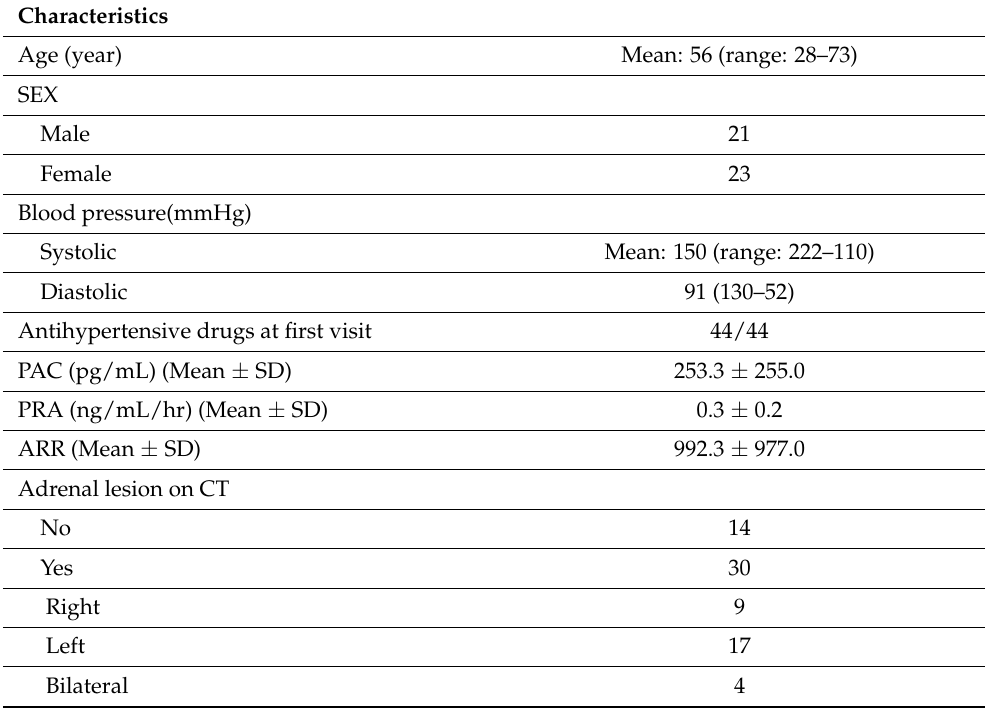
Table 1. 44 participants’ demographics and relevant clinical